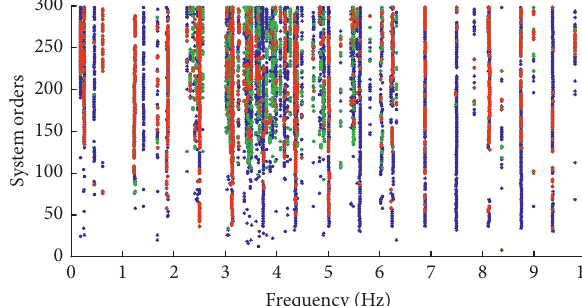
Figure 16: Stability diagram of the improved EEMD method.